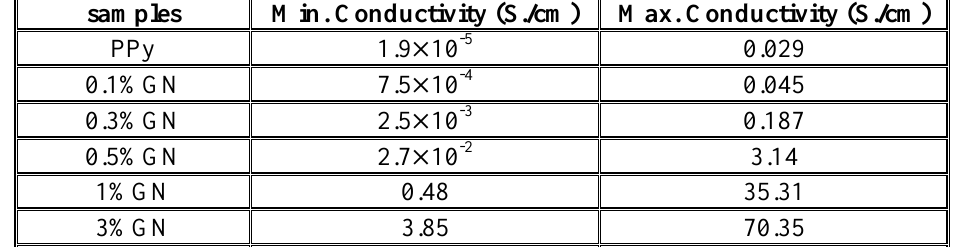
Table 1: The electrical conductivity as a function of temperature. samples